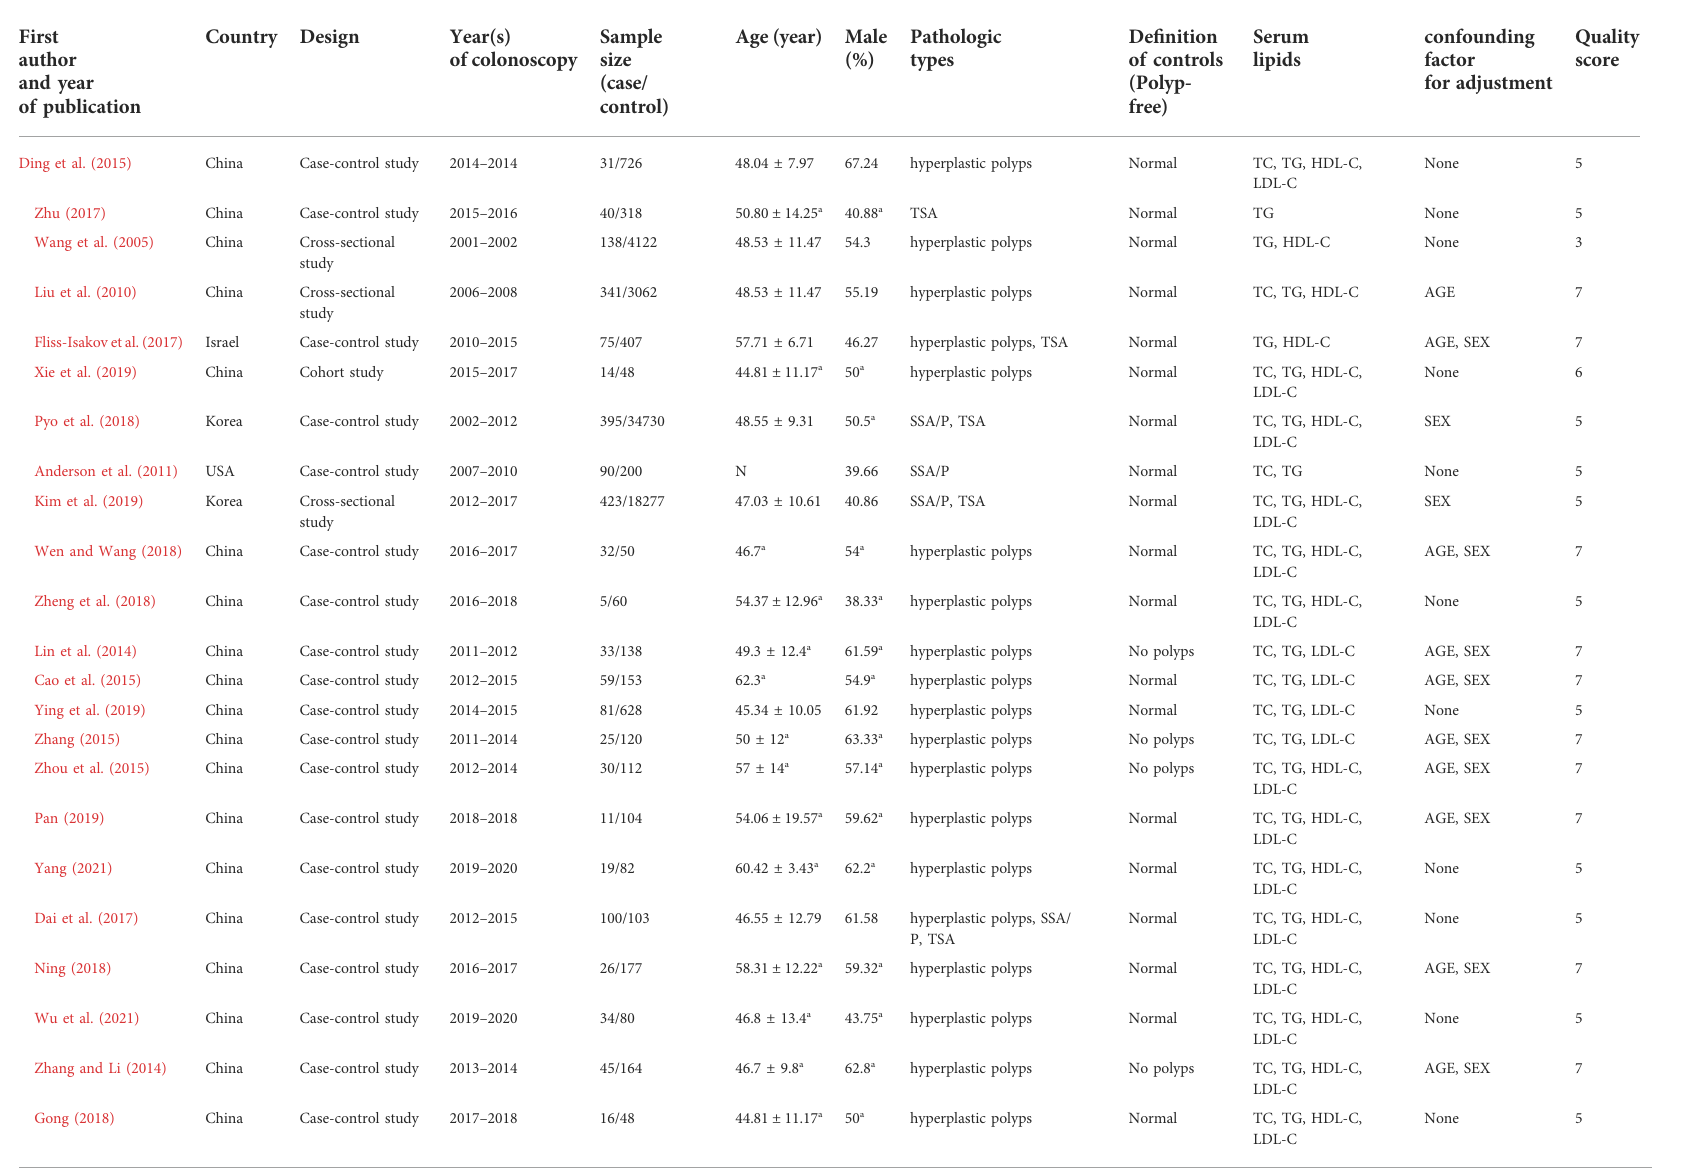
TABLE 1 The characteristics of the included